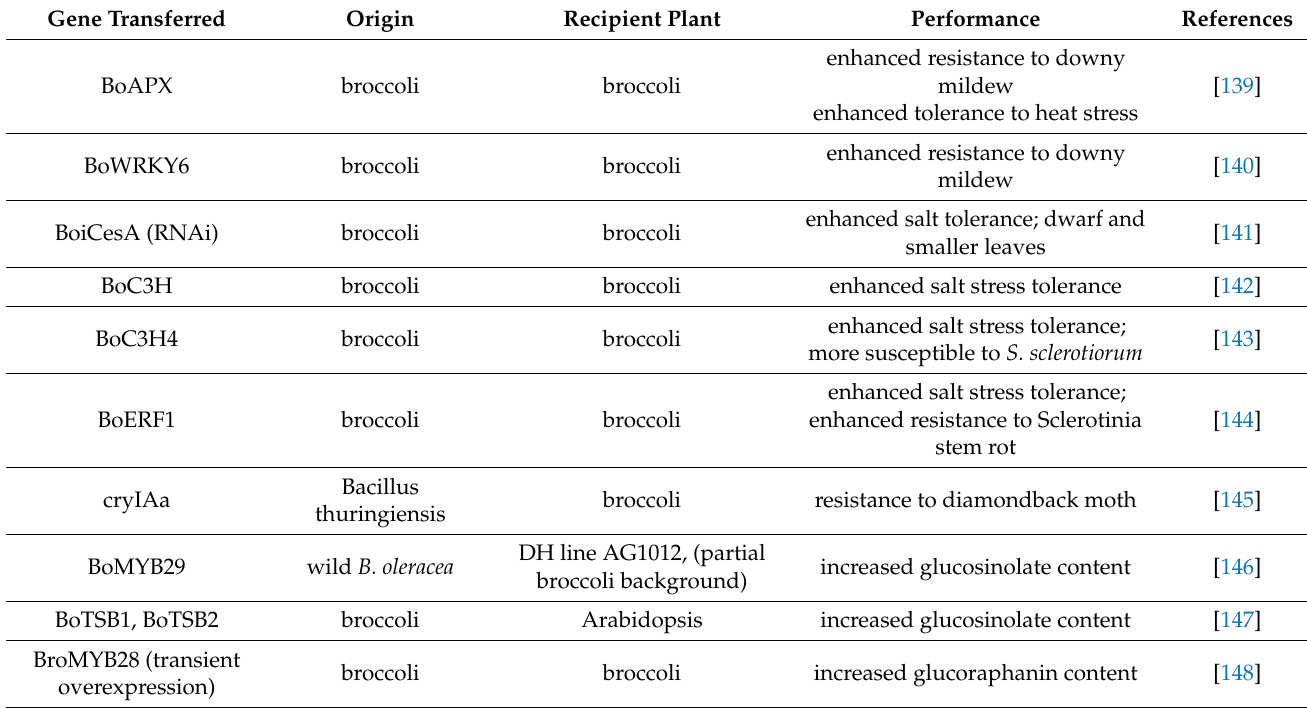
Table 1. Broccoli improvement by genetic transformation in recent